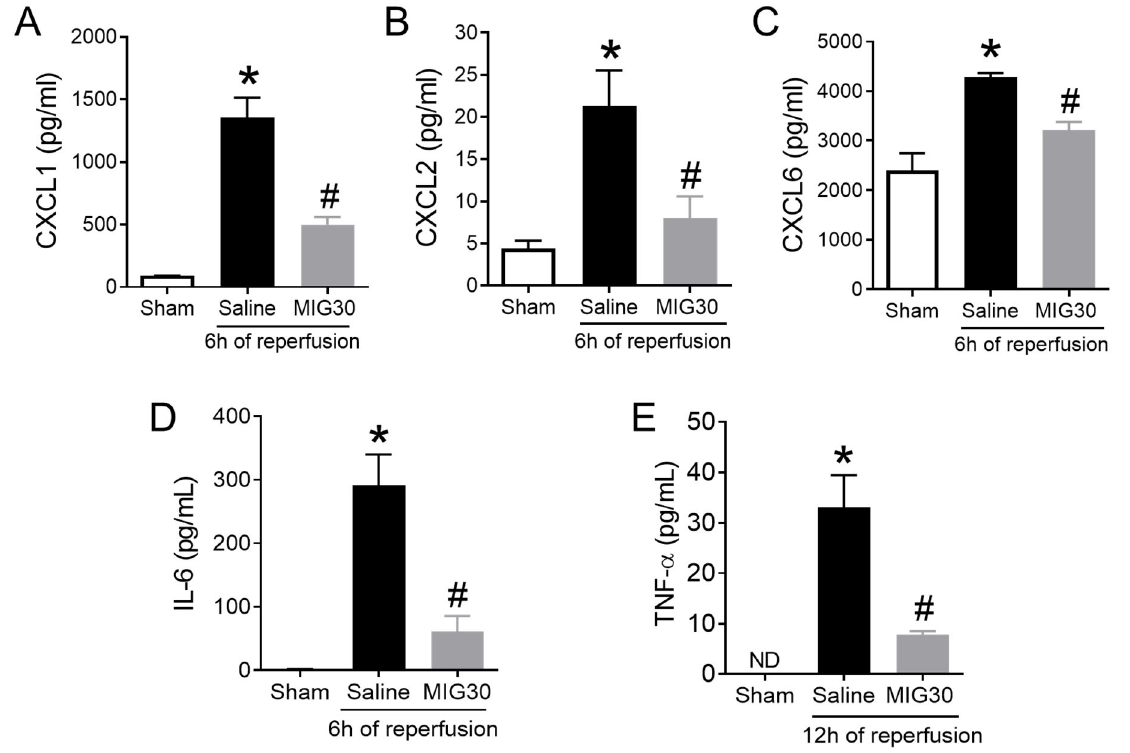
Figure 4. The levels of CXC chemokines and proinflammatory cytokines are reduced in MIG30- treated mice. Quantification of ( A ) CXCL1, ( B ) CXCL2, ( C ) CXCL6, ( D ) IL-6 and ( E ) TNF- α in the sera of mice subjected to liver IRI. Sham operated mice were used as control. IRI mice were either treated with saline vehicle or with MIG30 peptide (100 μ g 15 min before the reperfusion and again 6 h later, i.v.). CXCL1, CXCL2, CXCL6 and IL-6 were measured at 6 h of reperfusion. TNF- α was measured 12 h post reperfusion. ND = Not detected. The data shown are the mean ± SEM; n is at least 4 mice per group. * p < 0.05 vs. sham group; # p < 0.05 vs. saline ‐ treated mice.